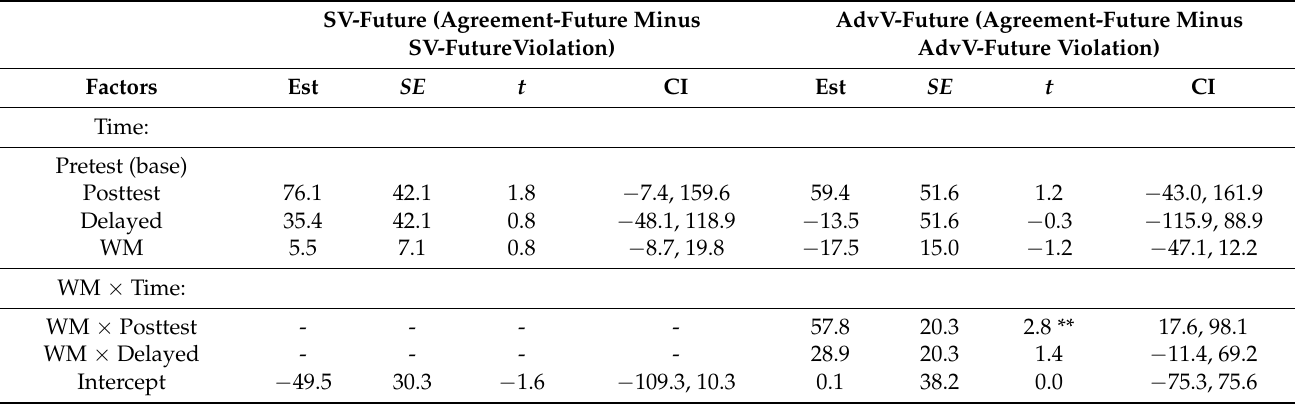
Table 9. Output for SV-Future and AdvV-Future Reading Time Difference Score Outcomes from Linear Mixed-Effects Models Including Only Training Participants and Fixed Effects of Time, WM, and Time × WM